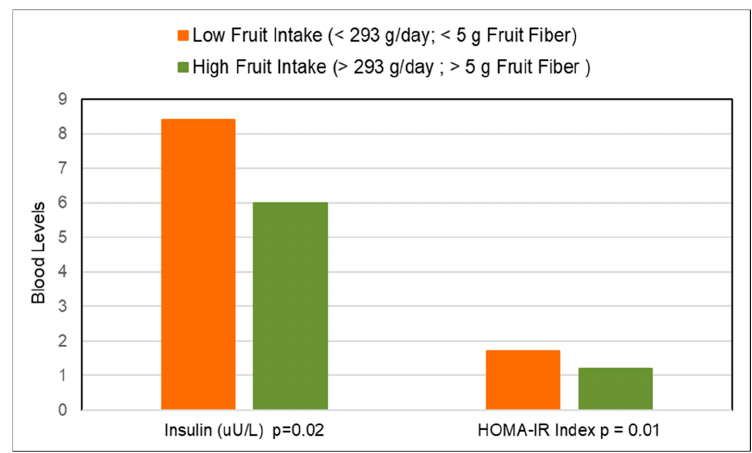
Figure 14. Association between fruit and fruit fiber intake on insulin sensitivity measures in 40 normal-weight young women with low to normal TNF- α values [214].